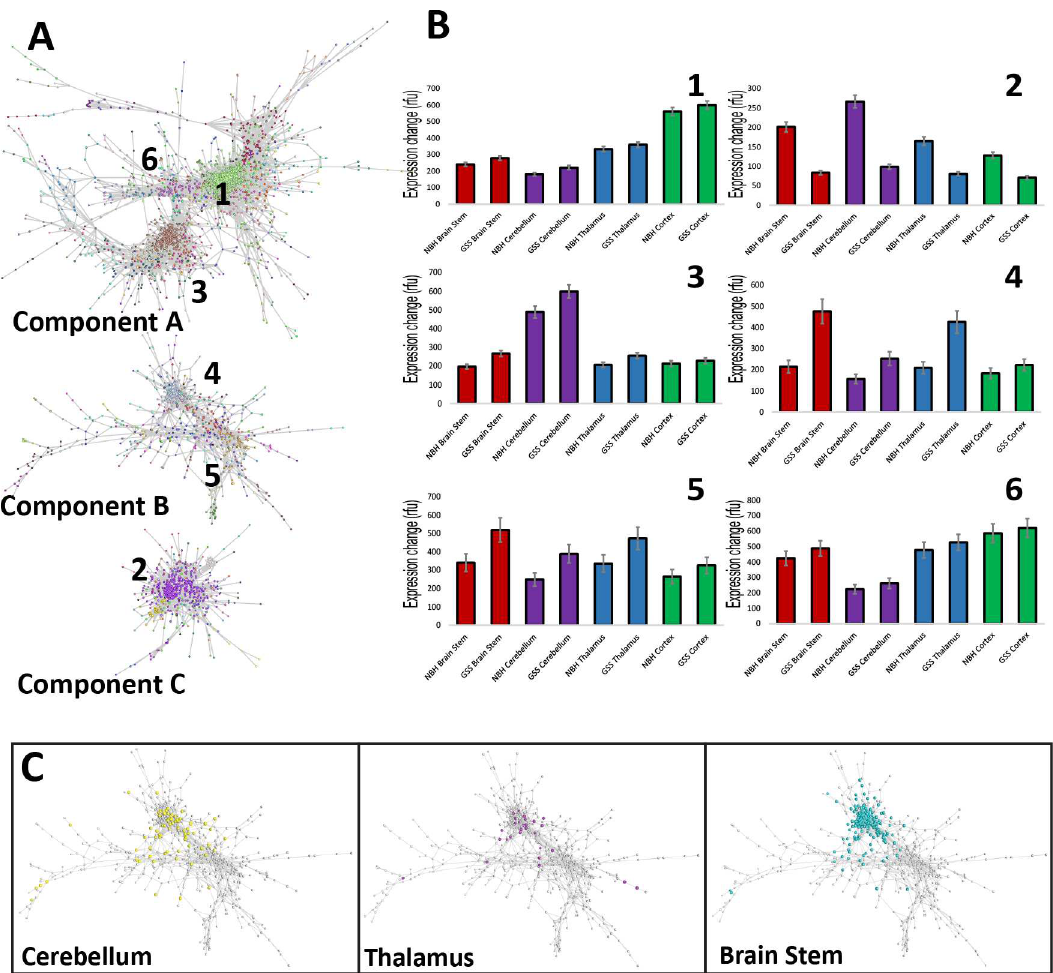
Fig 6. All GSS/101LL brain regions show disease-associatedgene expressionchanges. (A) Biolayout Express 3D graph showinga spatialrepresentation of genesorientatedaccordingto their correlationto one another. Three major and separatecomponentsof highly correlatedgeneswere formed using this software, which we term componentsA–C. This structure was used by the Markov clusteringalgorithmto dividethe graph into clusters of co-expressed transcripts, which are shown in the graph as different colours. Representative clusters, shown as numbers1–6, are shown on the graph, which highlightsthe expressiondifferences found betweeneach of the three major components identified.These can be viewedas averagegene expressionas bar graphs(B). (C) Filtered gene lists from the GSS/101LL cerebellum, thalamus, and brain stem are overlaidonto the originalgraph. Shown here are the filtered geneshighlightedin yellow (cerebellum), purple(thalamus), or turquoise(brain stem) as part of componentB of the main graph shown in (A). The highlightedgenes in each brain region were observedpredominantlywithin the same part of the graph rather than segregatinginto distinct groups, demonstrating that these differentiallyexpressed genes betweenbrain regions were highly